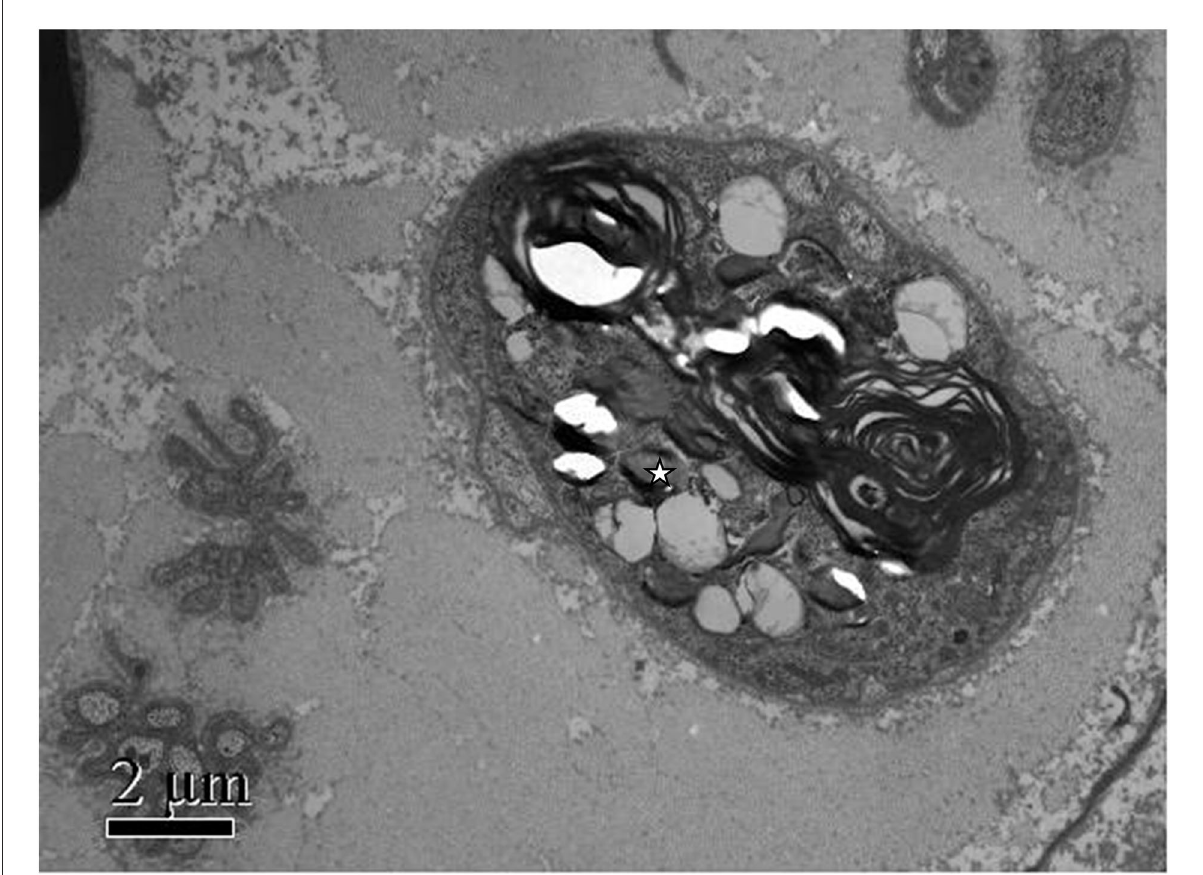
FIGURE2 Patient’s photograph of the sural nerve biopsy specimen. Electron microscopic findings: Myelinated nerve fibers were extensively destroyed. Wallerian degeneration could be observed (white star), and Schwann cells and macrophages were not observed. Scale bars: 2 µ